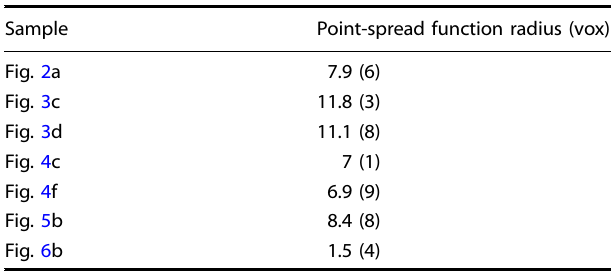
Table 2. Point-spread function for µCT data.